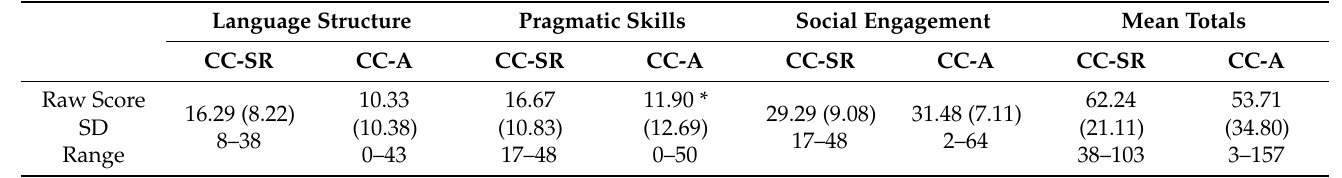
Table 4. Descriptive comparisons between CC-SR and CC-A raw scores for 21